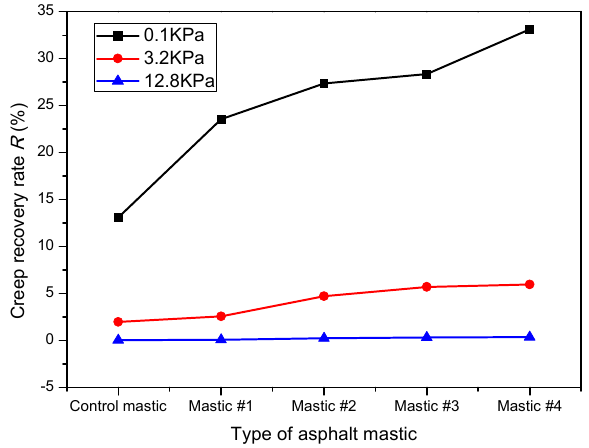
Figure 10. Non-recovery creep compliances.